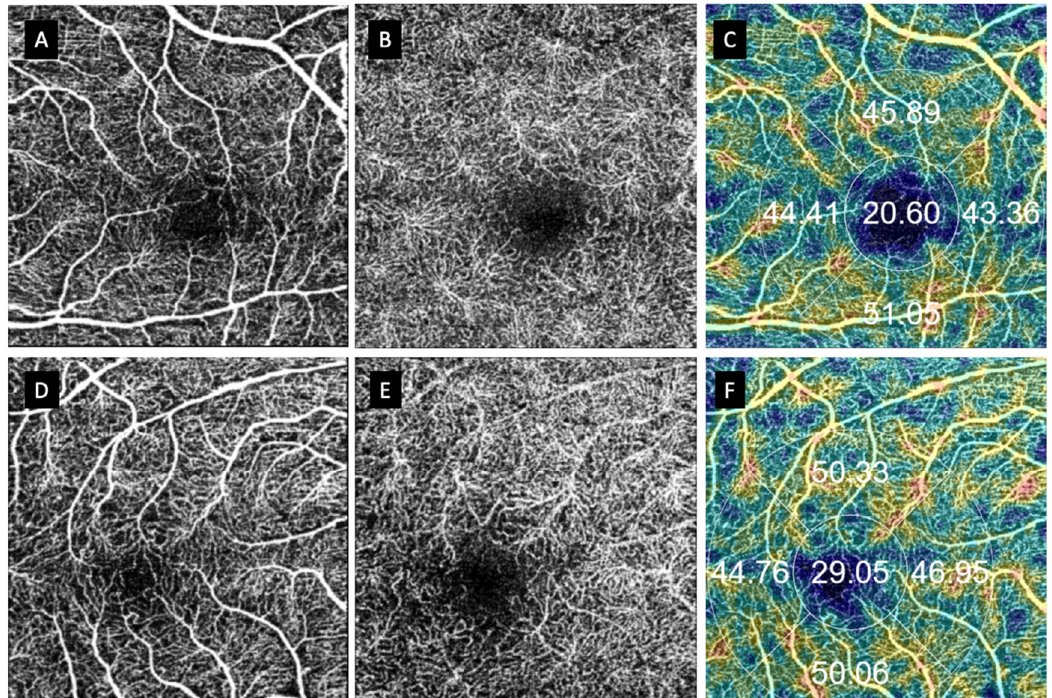
Figure 5. Anatomical finding in patients with macula-off RDD vs. their fellow eyes. ( A – C ) Macula-on RDD. ( D – F ) Contralateral healthy eye. ( A , D ) represent superficial capillary plexus (SCP); ( B , E ) represents deep capillary plexus; and ( C , F ) represents vessel density in the SCP.